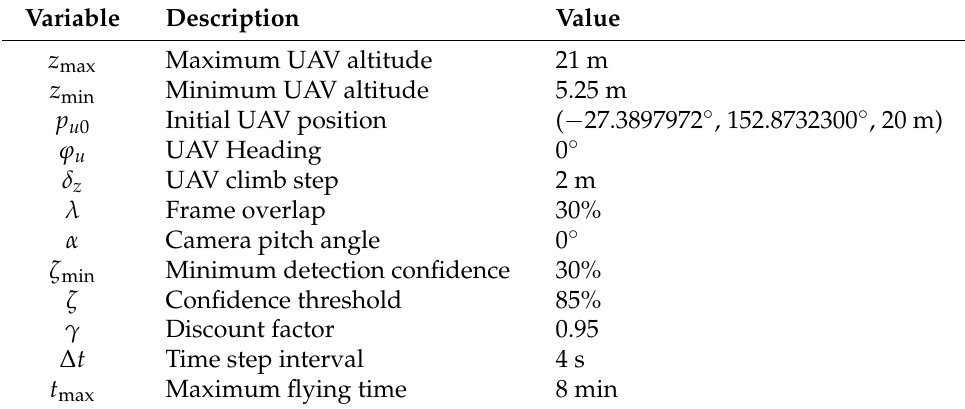
Table 4. Initial conditions set to the POMDP motion planner.